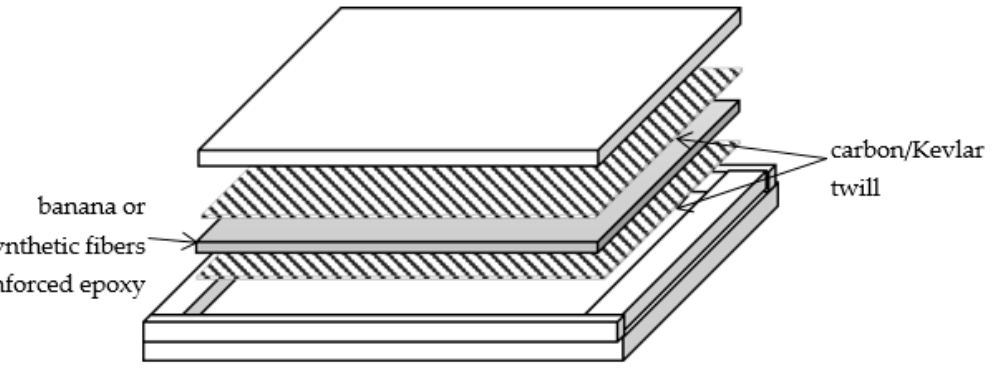
Figure 3. Schematic of the fiber-reinforced epoxy sandwich structure fabrication.